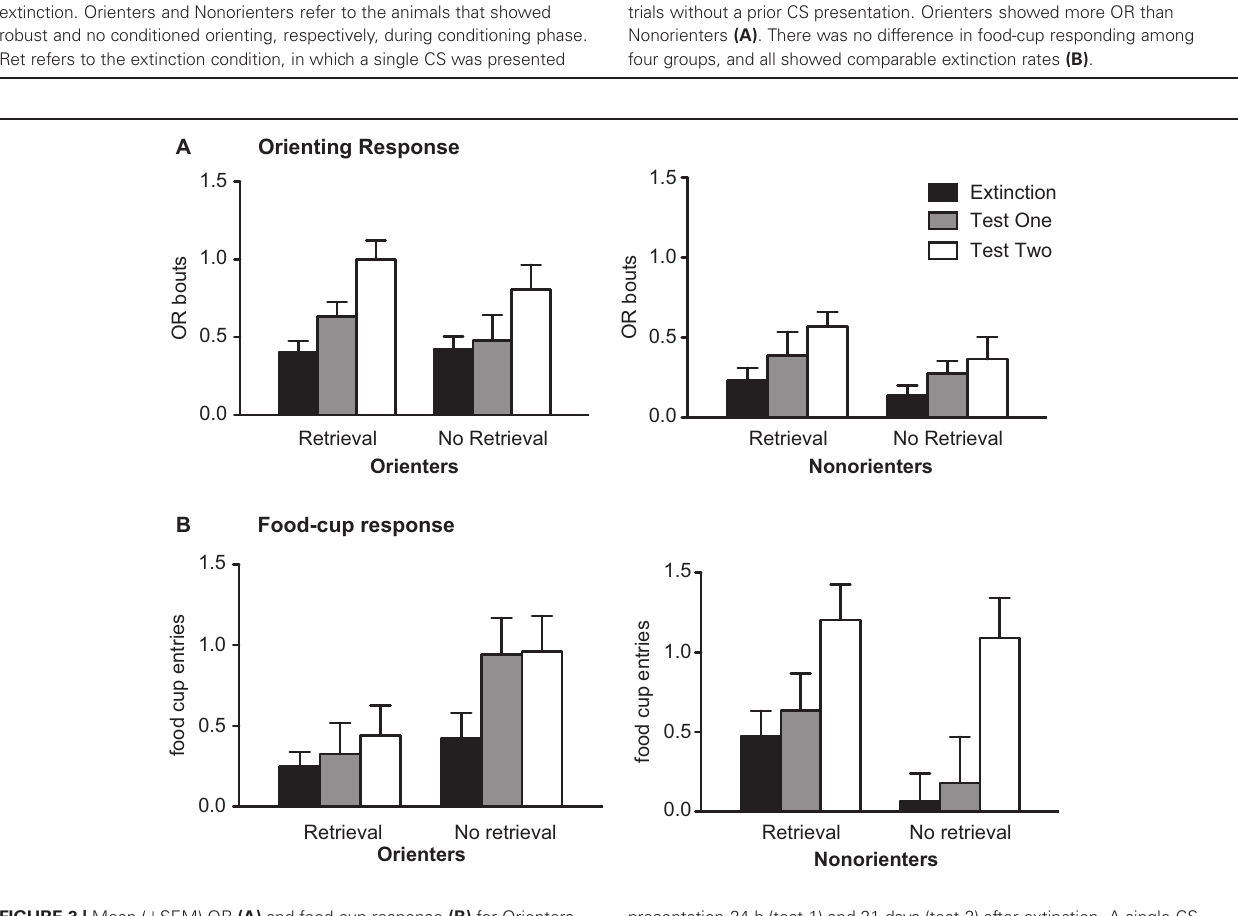
FIGURE 3 | Mean ( ± SEM) OR (A) and food cup response (B) for Orienters (left panels) and Nonorienters (right panels). The values are responses during the last four CS alone presentations in extinction session, four CS alone spontaneous food-cup response only in